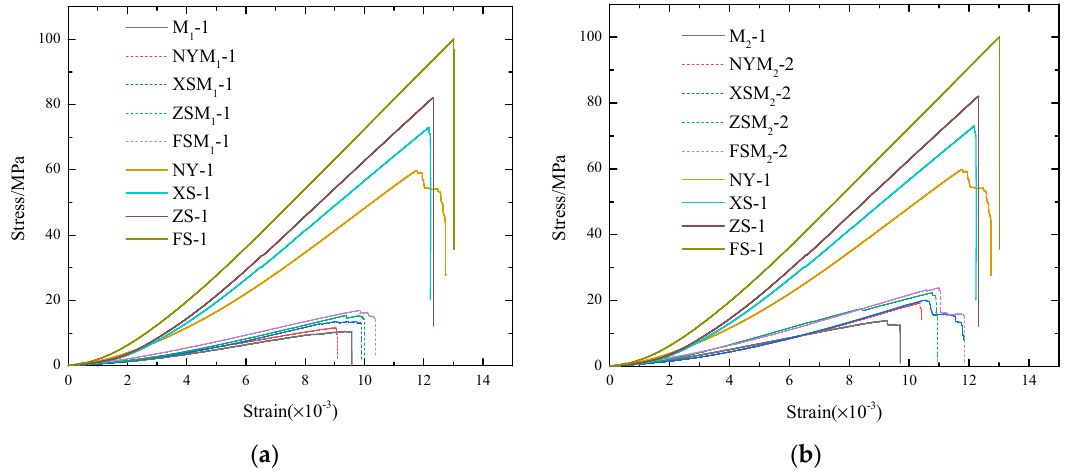
Figure 3. Typical stress-strain curves of pure coal/rock and CRC specimens: ( a ) #1 coal and ( b ) #2 coal.